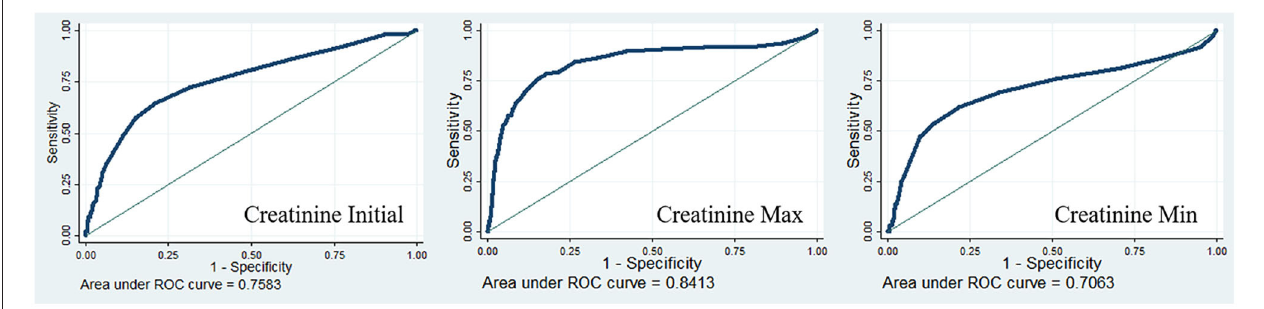
in inflammation. Cytokines and chemokines recruit